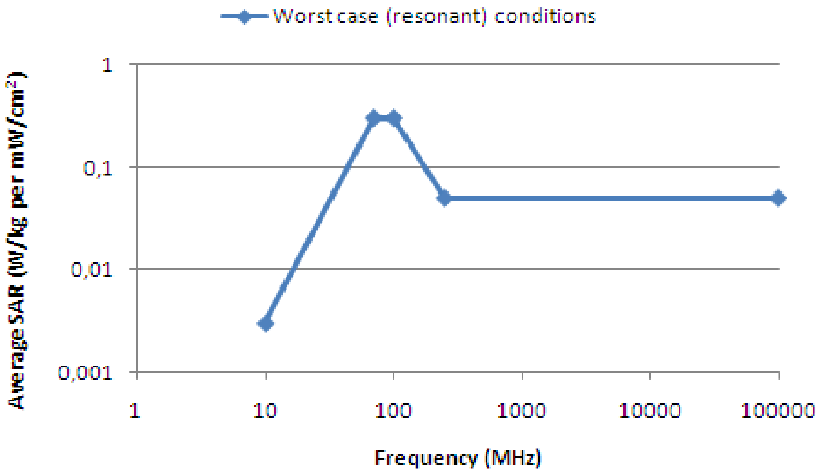
Figure 13. Radiation absorption by the human body vs . frequency [9].